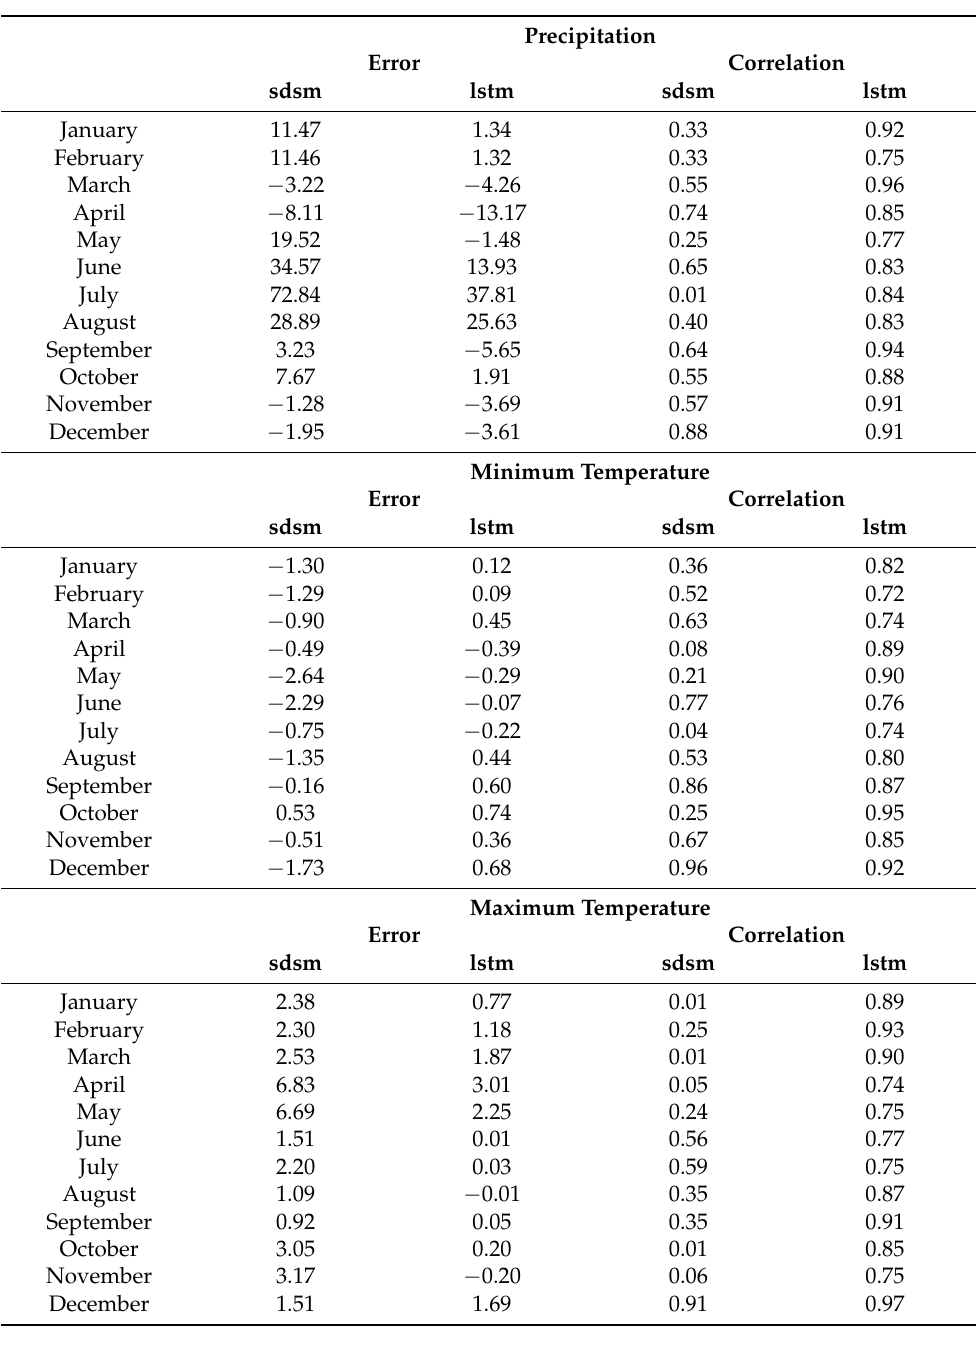
Table 6. Monthly predictions biases and monthly correlations between observed and predicted